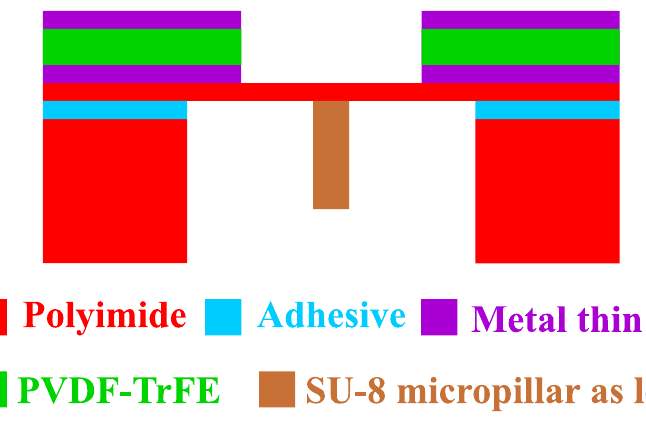
Figure 6. Cross-section view of the MEMS mass sensor to be